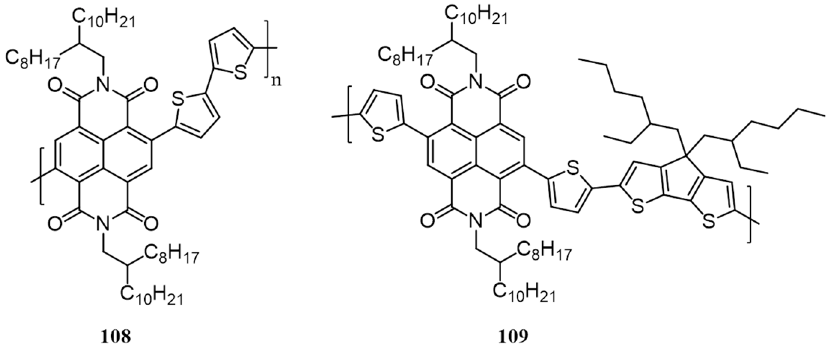
Figure 37. Chemical structure of copolymer acceptors ( 108 and 109 ) synthesized by Neher et al. [121].